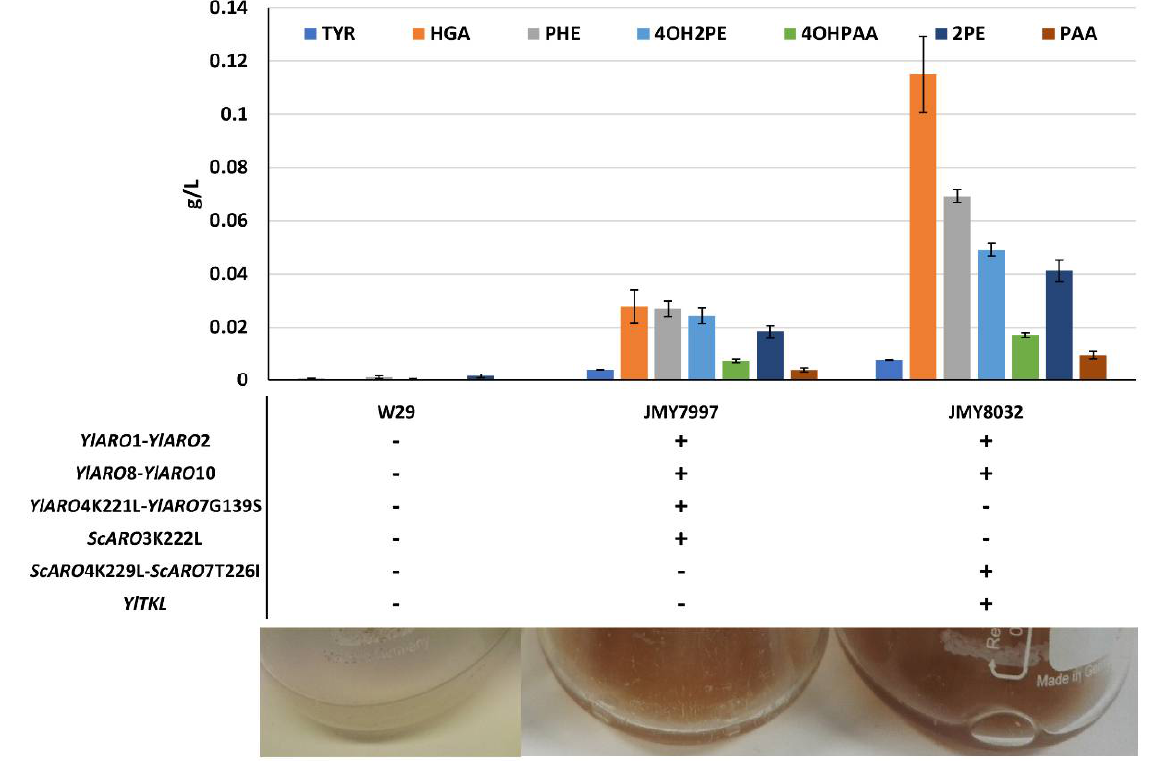
Figure 2. Production of pyomelanin precursors. Top : Concentrations of tyrosine (TYR), phenylalanine (PHE), homogentisic acid (HGA), phenylethanol (2PE), phenylacetic acid (PAA), 2-(4-hydroxyphenyl)ethanol (4OH2PE), and 4-hydroxyphenylacetic acid (4OHPAA) in the supernatants of the three strains at 5 days of culture. Values correspond to average of 2 replicates. Middle : Strain genotypes. Bottom : Images illustrating pigmentation levels in the cultures at 25 days of growth.